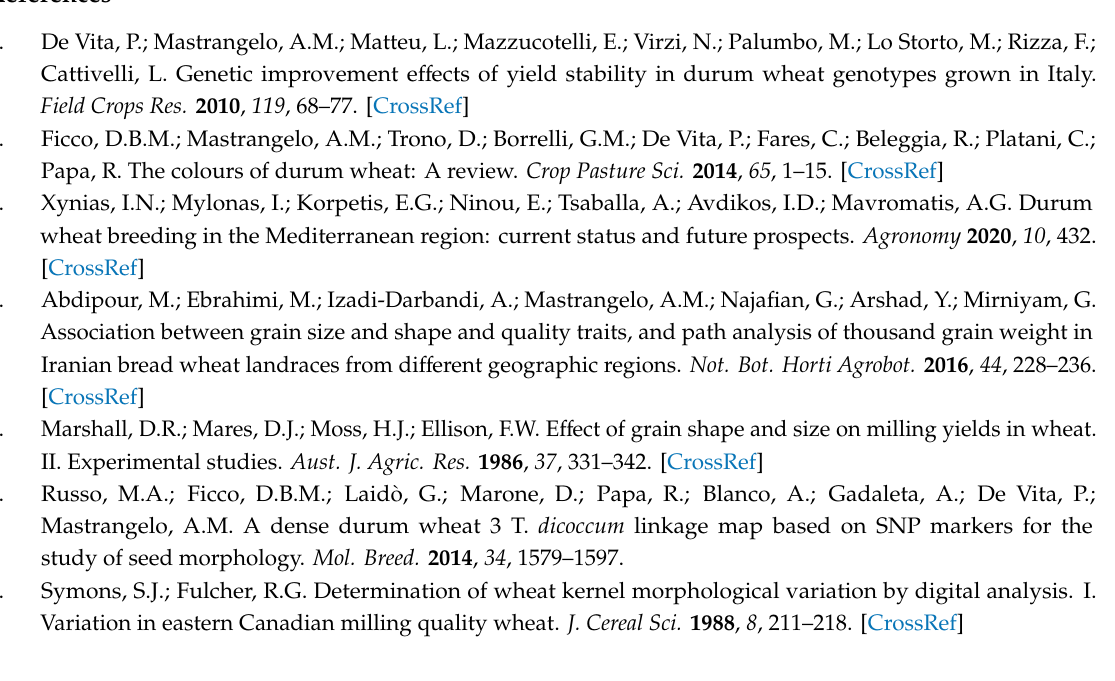
Table S1 (Supplemental Material). Milling (wholemeal and semolina) and debranned kernel flours (DK1–DK6) of four genotypes over three environments: quantification of ash and macro-elements (a) and micro-elements